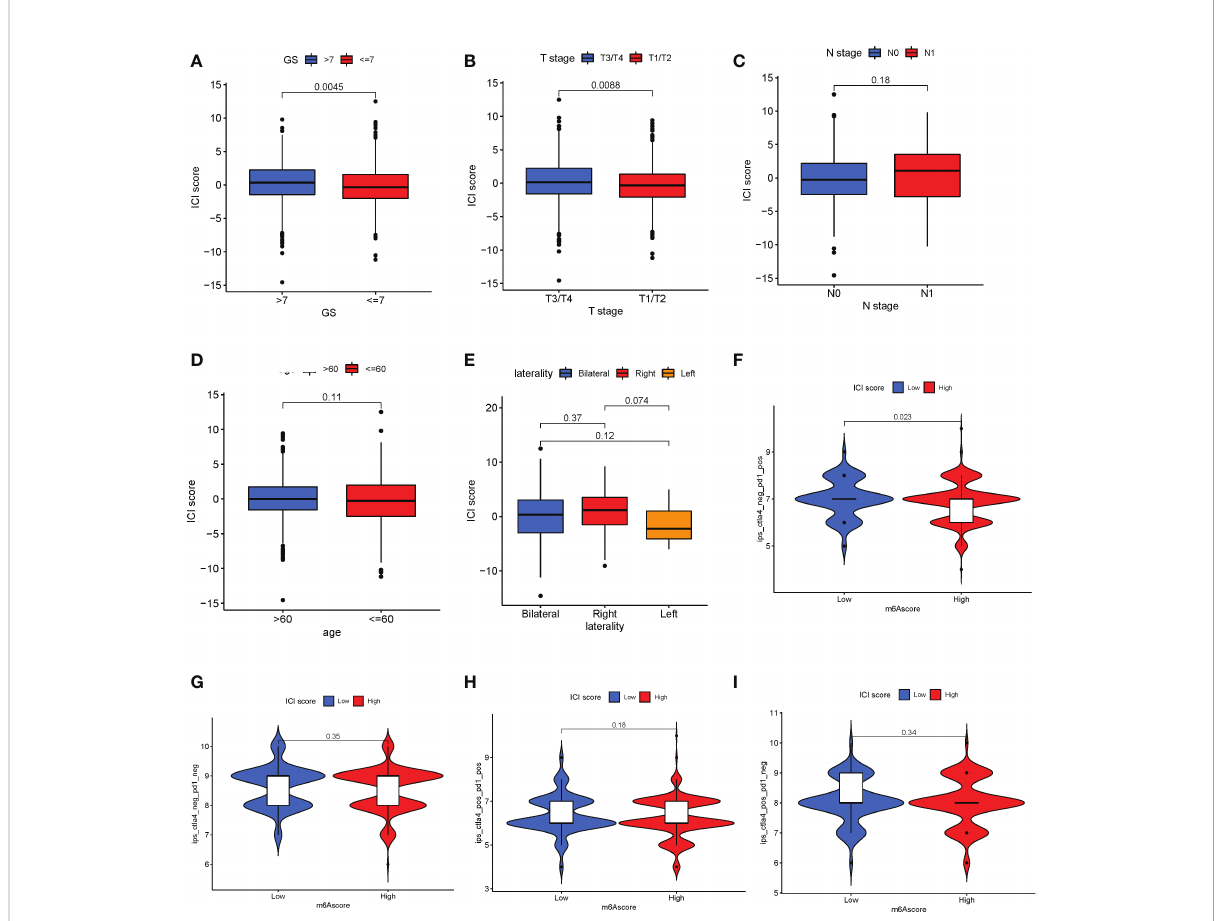
FIGURE 7 Correlation between immune cell in fi ltration (ICI) scores and major clinical features of patients with prostate cancer. (A) Correlation between the ICI and Gleason scores (Wilcoxon test, P = 0.0045). (B) Association between T stage and ICI scores (Wilcoxon test, P = 0.0088). (C – E) The N stage (C) , age (D) , and laterality € parameters have no signi fi cant correlation with the ICI score. (F) Patients with a low ICI score have a better immune response to the IPS-CTLA4-neg-PD1-pos immunotherapy ( F ; log-rank test, P = 0.023). (G – I) No signi fi cant difference in immunophenotype scores in patients with high and low ICI